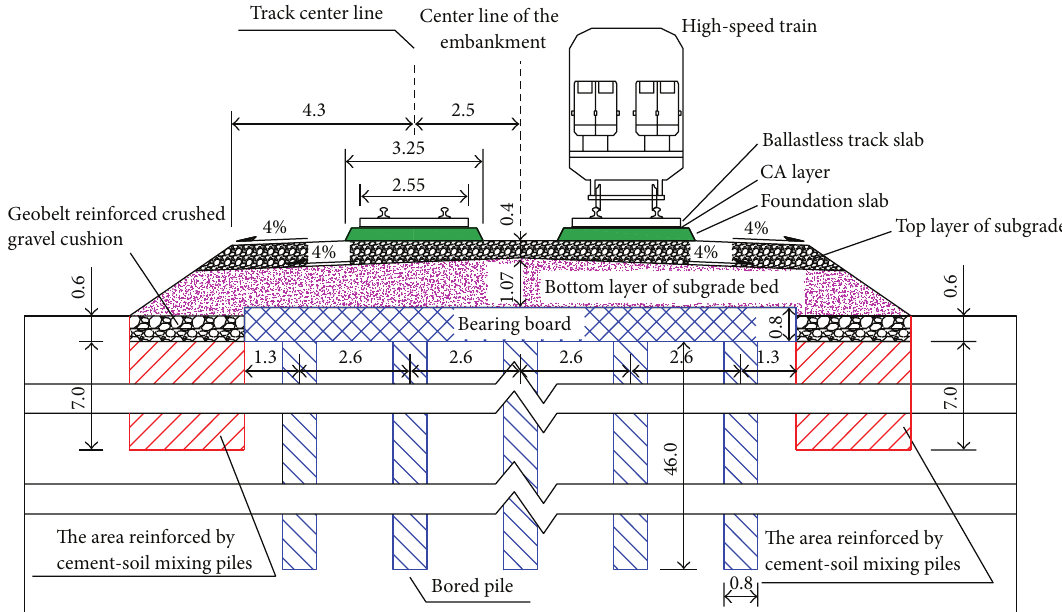
Figure 4: Geometry of the coarse particle sandwich structure of low